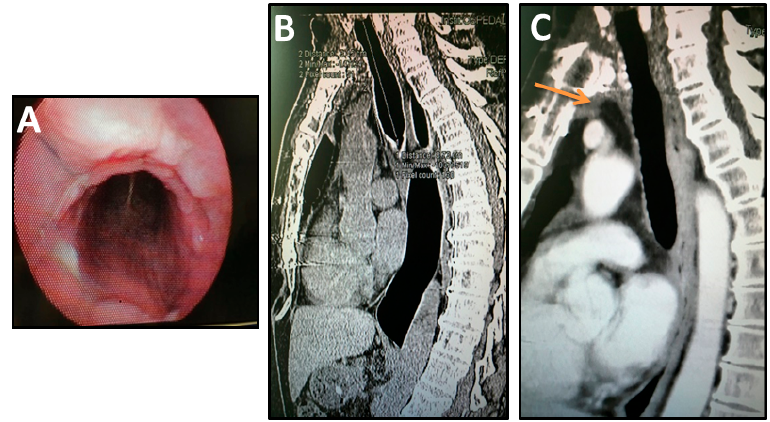
Figure 3. ( A ) Integrity of the tracheal anastomosis at discharge. Followup at six months: no evidence of residual disease ( B ) and persistence of the reverse thymic fat pad ( C ) between the trachea and brachiocephalic vessels at CT scan